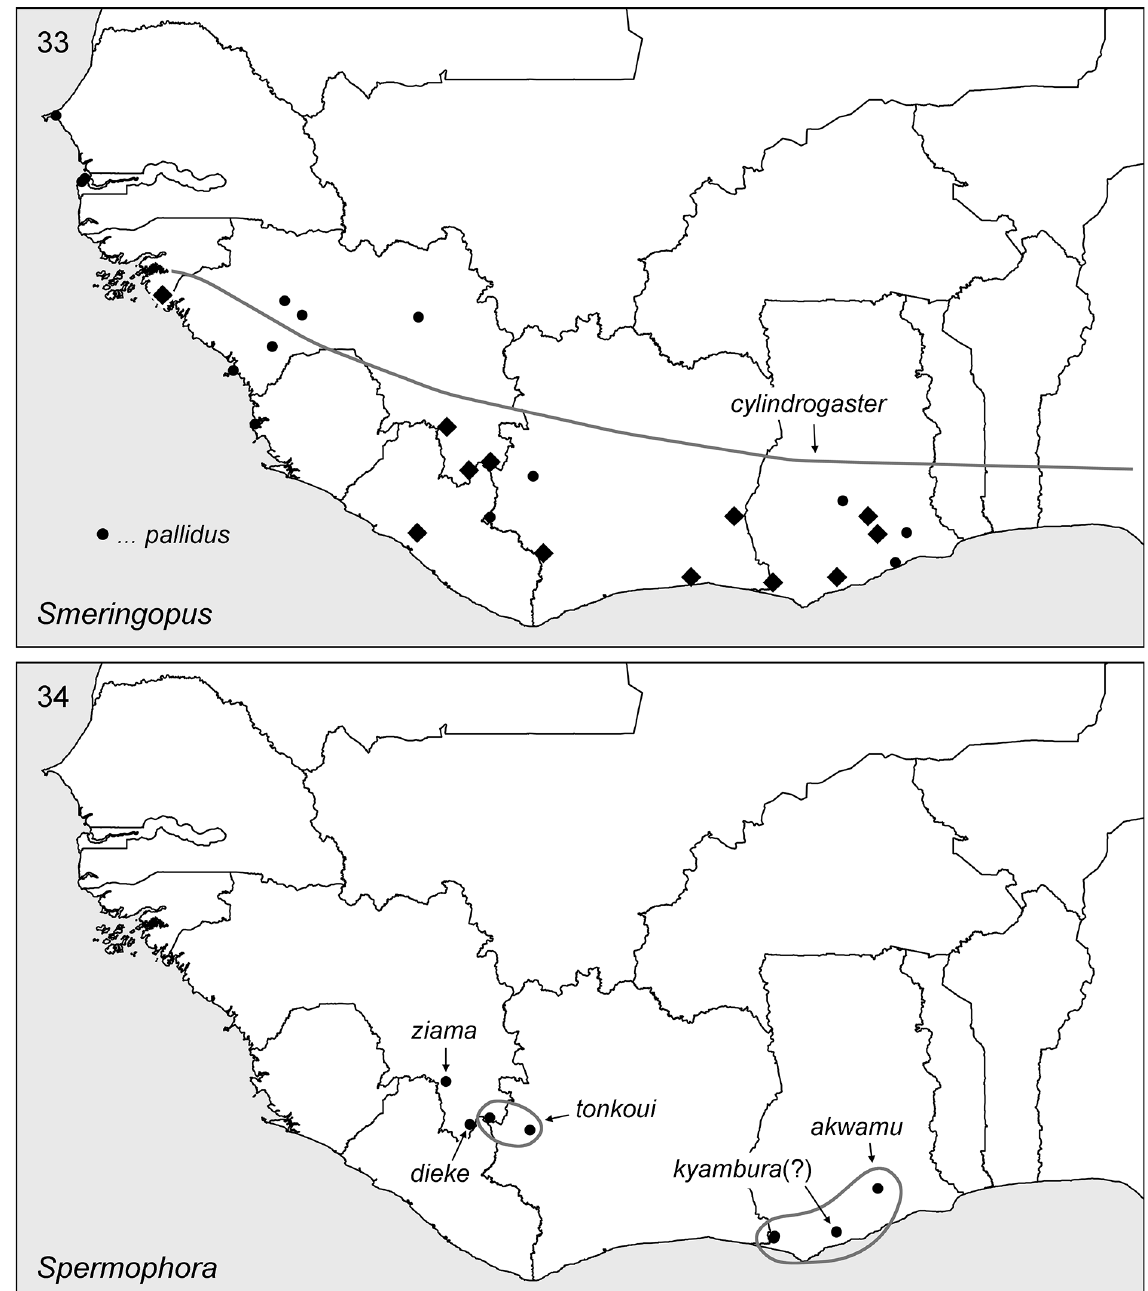
Figs 33-34. Known distributions of the genera Smeringopus Simon, 1890 and Spermophora Hentz, 1841 in West